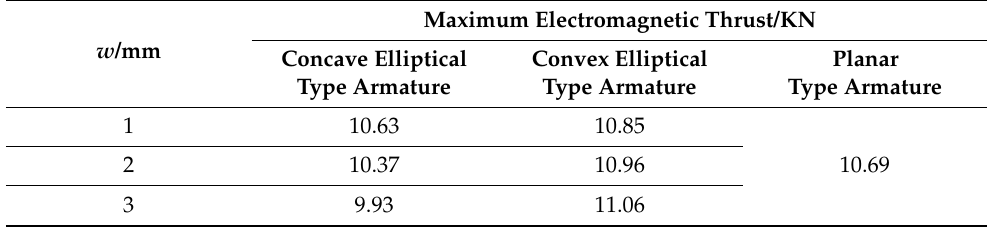
Table 5. Maximum electromagnetic thrust for different configurations of armatures.